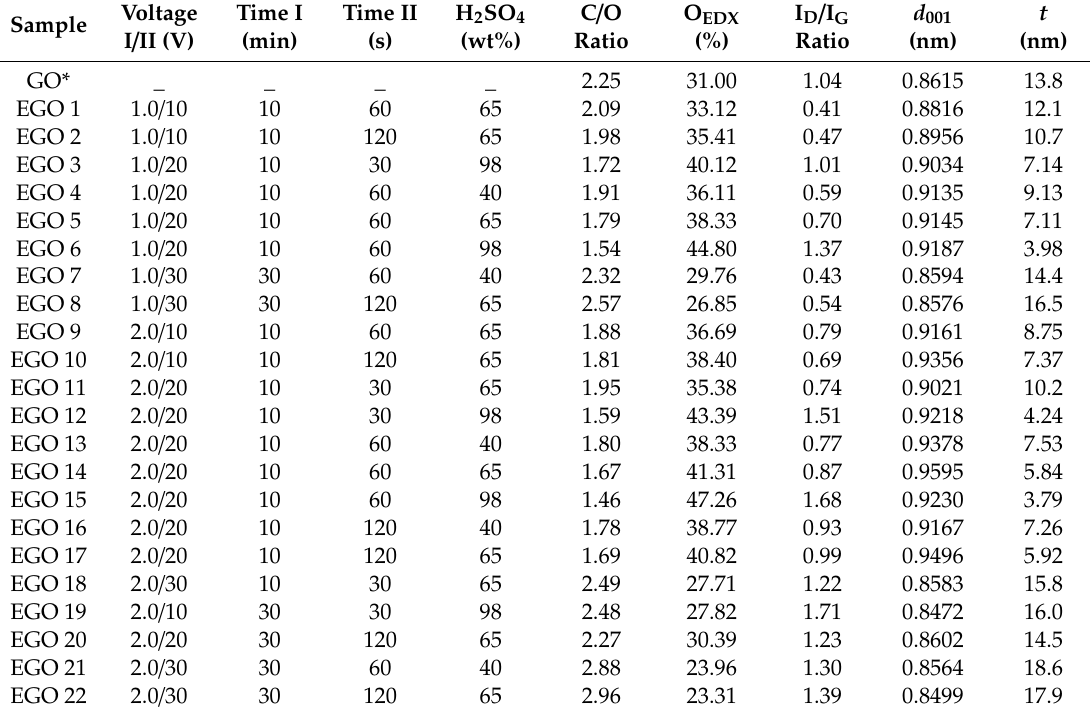
Table 1. Nomenclature, experimental conditions of the electrochemical synthesis, and characteristics of the di ff erent EGO